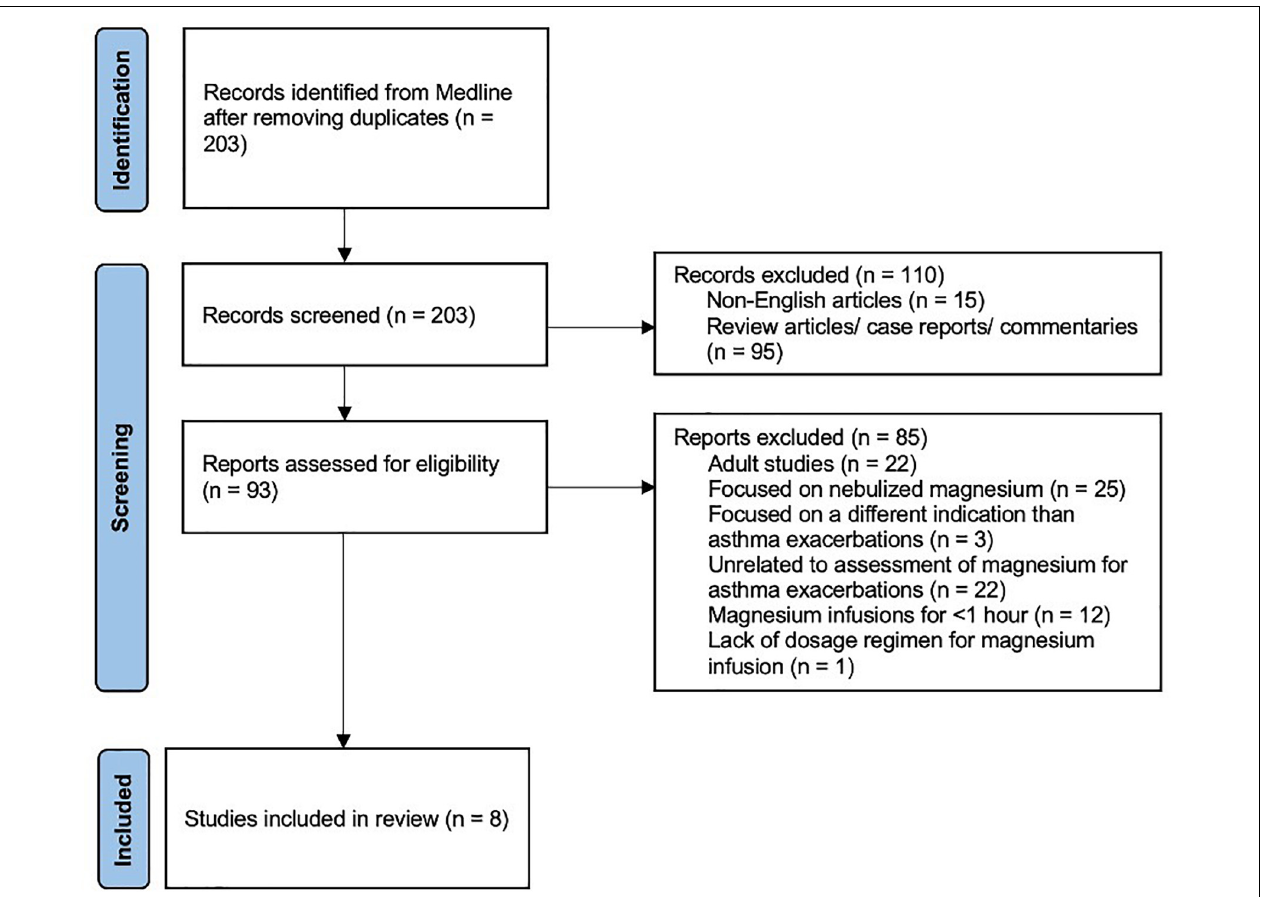
FIGURE 1 | PRISMA flow diagram of included